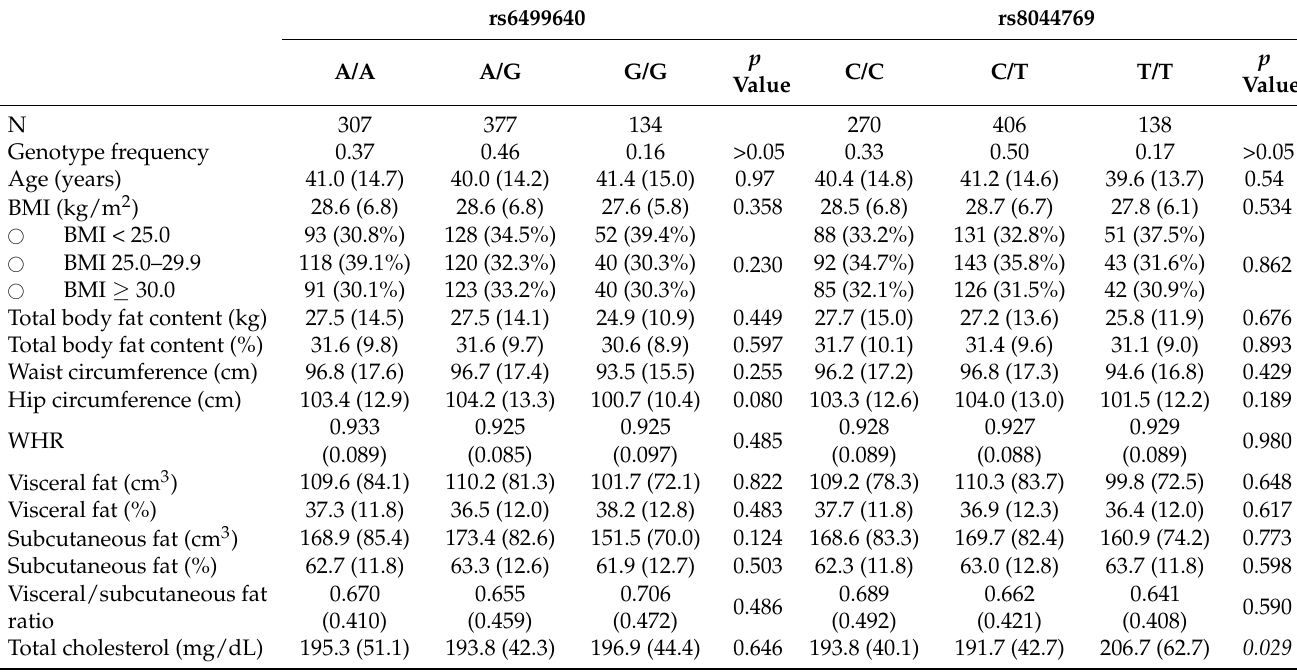
Table 2. Characteristics of participants stratified by rs6499640 and 8044769